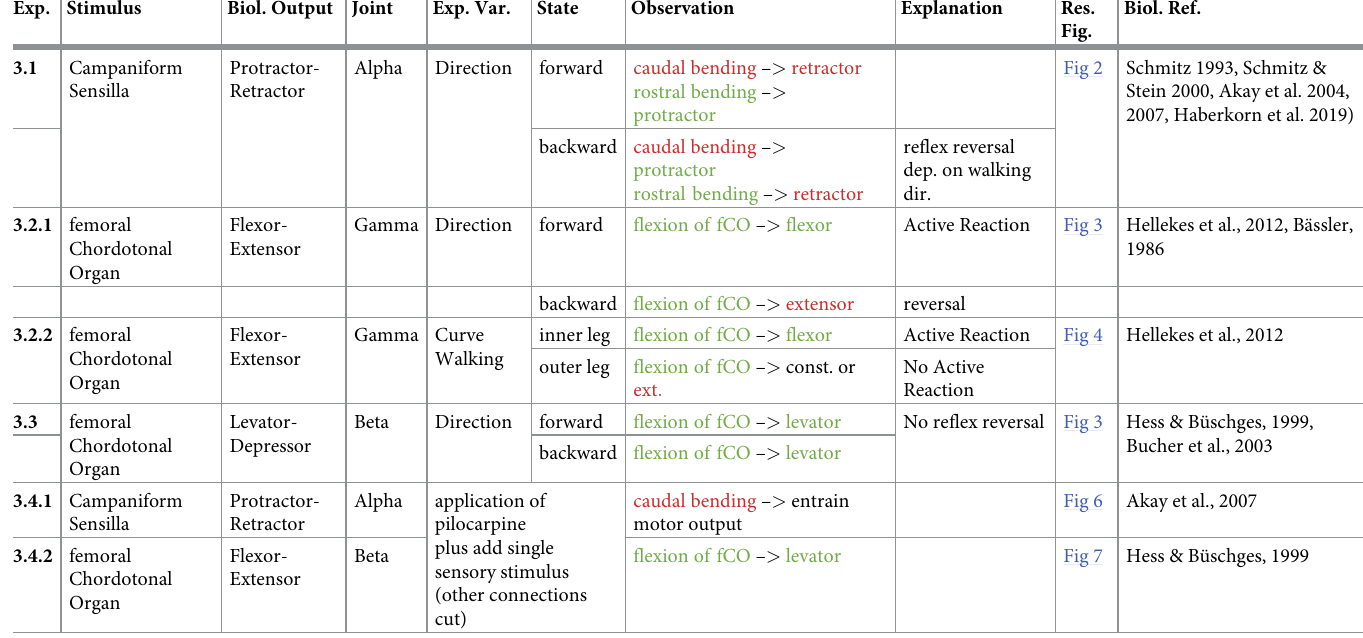
Table 1. Overview of performed experiments and summary of the biological experiments. Exp.